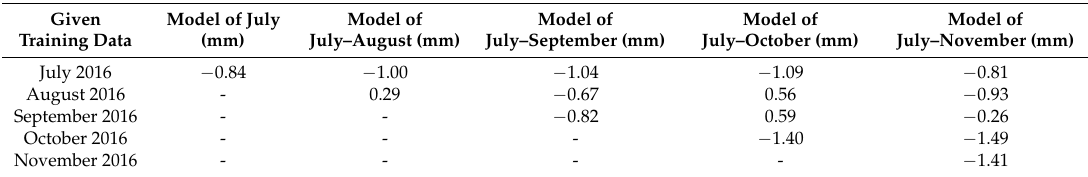
Table 3. ME values with respect to different sets of training data.